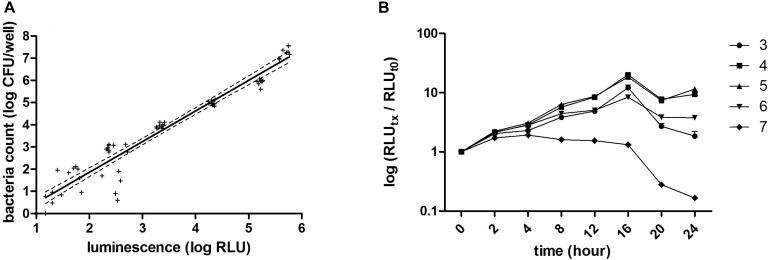
RLU–CFU correlation and optimization of inoculum and culturing time. (A) Different bacterial concentrations, ranging from 101 to 107 CFU/well were measured by luminescence (RLU) and by CFU counting. The linear regression [r2 = 0.9345, p < 0.0001, CFU = 1.37 (±0.05)*RLU – 0.88 (±0.19)] represented by the full line and its deviation indicated by the dotted lines correspond to three independent experiments done for each bacterial concentration in triplicate. (B) The bacterial growth kinetic was evaluated by reading luminescence after 0, 2, 4, 8, 12, 16, 20, and 24 h incubation of different concentrations of bacteria, ranging from 103 to 107 CFU/well, represented, respectively, by circles, squares, triangles, reversed triangles and diamonds. Each symbol represents the mean of three independent experiments each done in duplicates. Luminescence read for each time point and for each bacterial concentration was normalized to its corresponding luminescence at time 0.